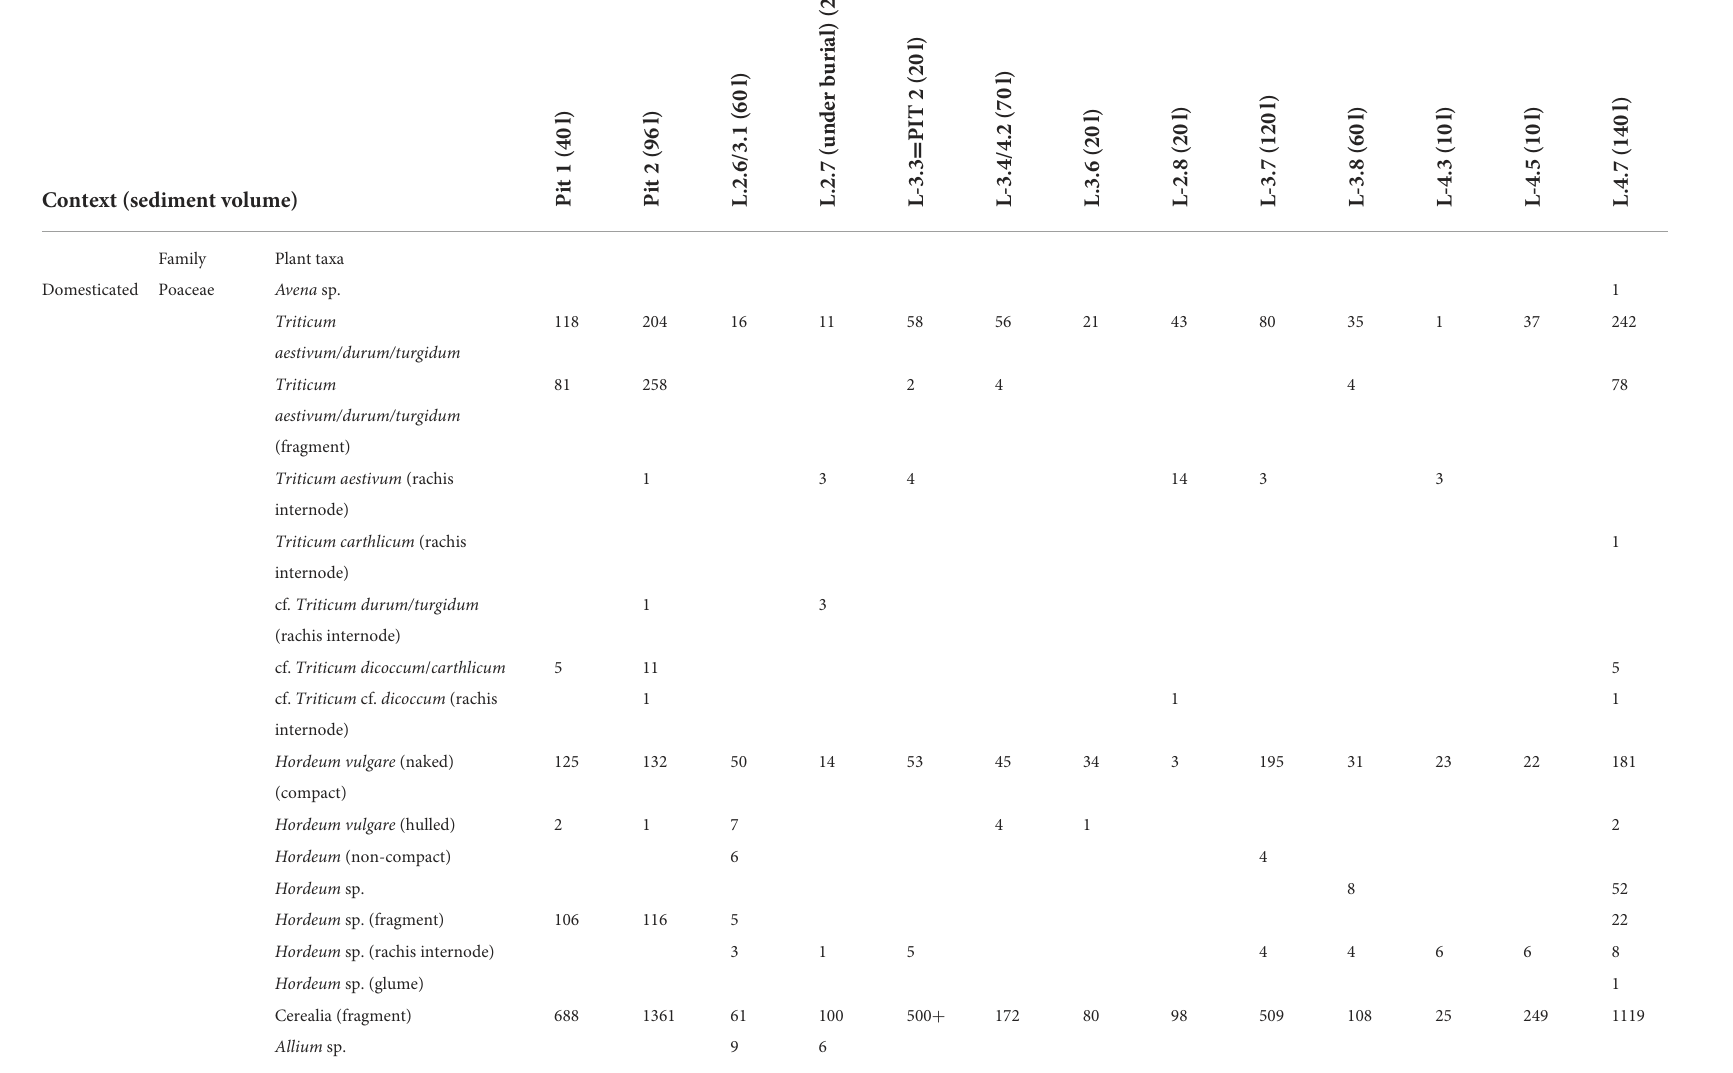
TABLE 1 Archaeobotanical identifications from Chap